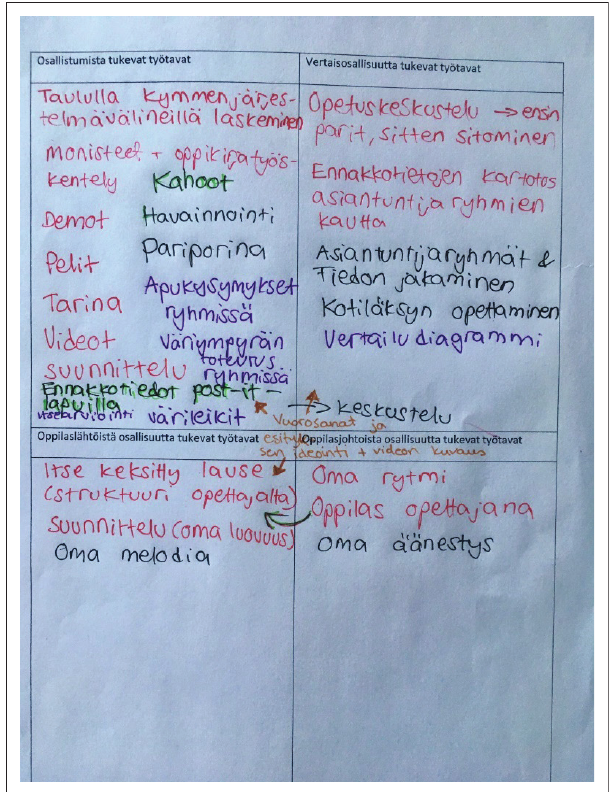
FIGURE 1: A documentation form that was used as a mentoring tool (Author’s own